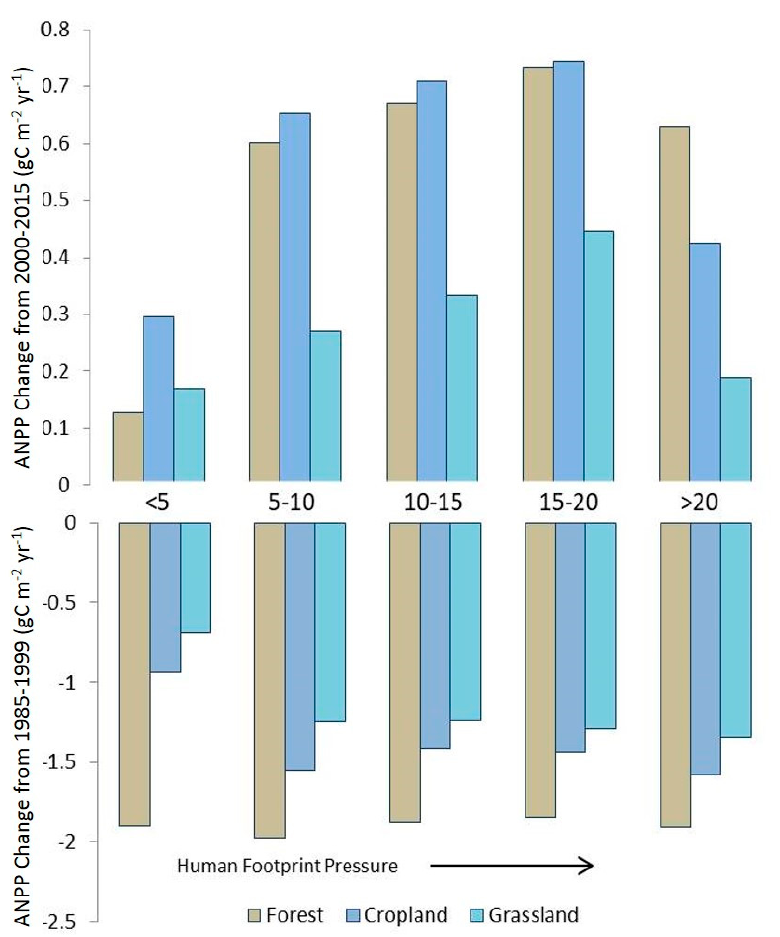
Figure 18. NPP change per unit area per year for the vegetation classes. 488